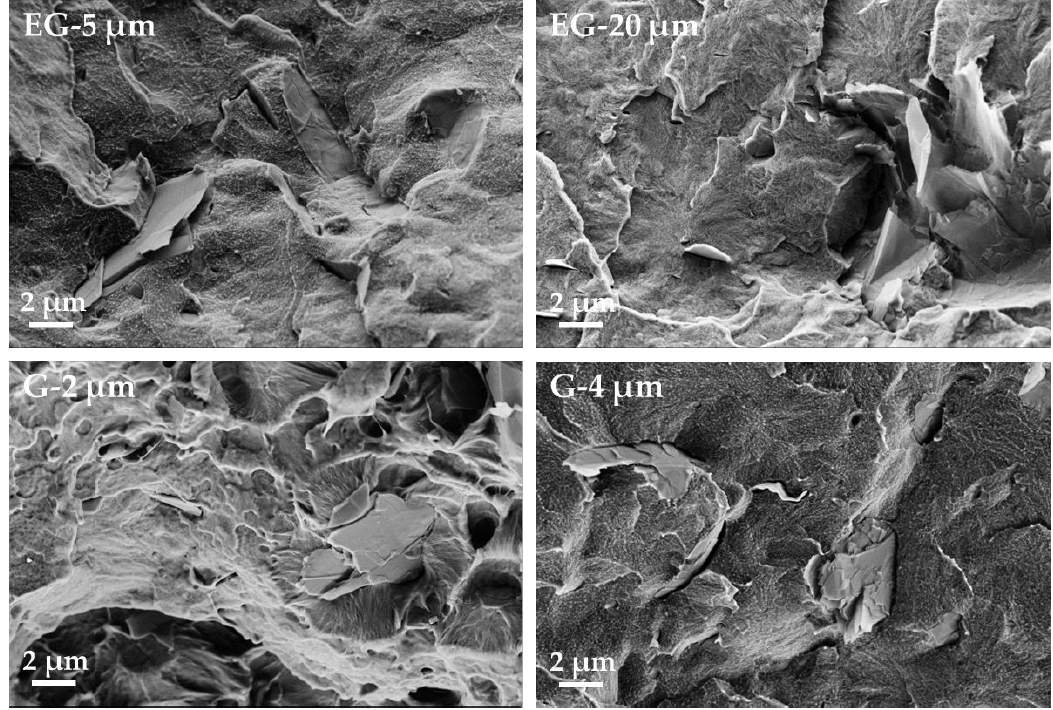
Figure 7. SEM micrographs of PVDF/1.0 wt% graphite composites filled with different kinds of expanded graphite (EG) and graphite (G).